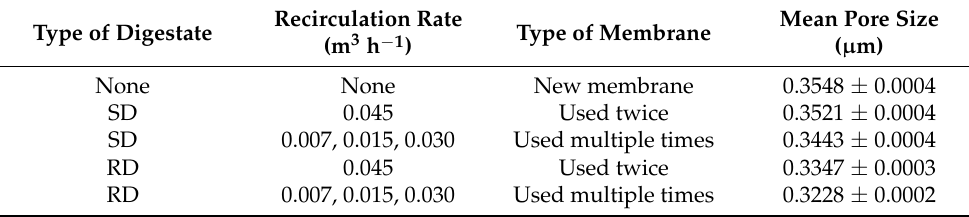
Table 5. Mean pore sizes of the PTFE-0.22 membrane under different operational